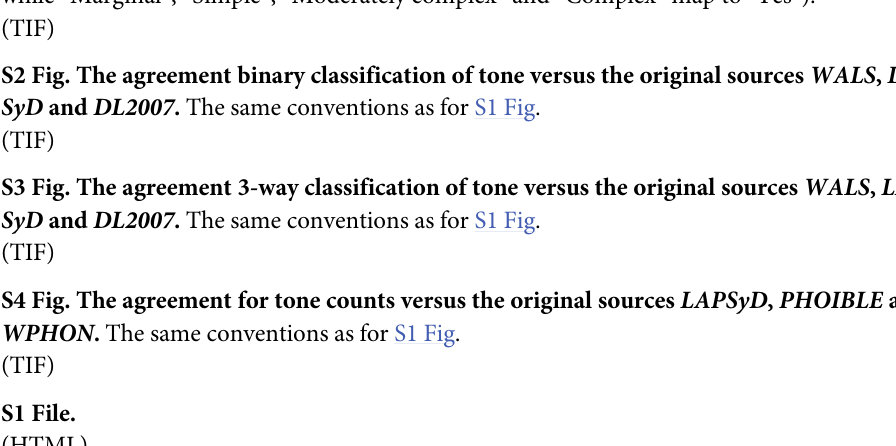
S2 Fig. The agreement binary classification of tone versus the original sources WALS , LAP- SyD and DL2007 . The same conventions as for S1 Fig. S3 Fig. The agreement 3-way classification of tone versus the original sources WALS , LAP- SyD and DL2007 . The same conventions as for S1 Fig. S4 Fig. The agreement for tone counts versus the original sources LAPSyD , PHOIBLE and WPHON . The same conventions as for S1 Fig. (TIF) S1